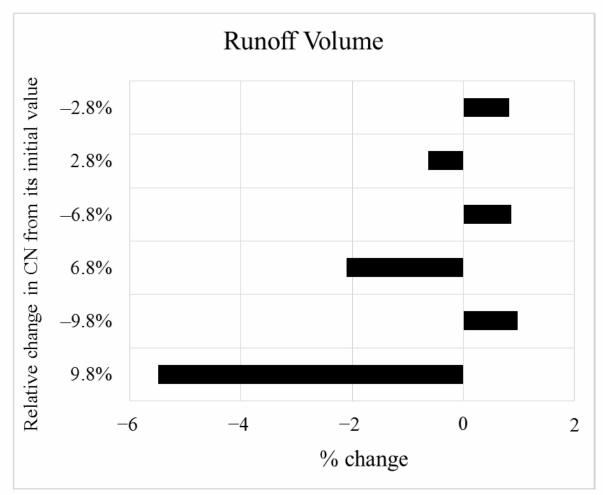
Figure 5. Sensitivity analysis for CN for a straight row crop with poor hydrological conditions; Sugar Creek watershed.